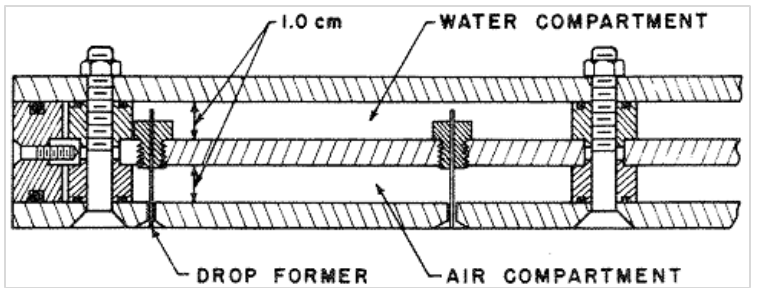
Figure 9. Box tank with drippers with air and water chambers [32] (Reprinted/adapted with per- mission from Ref. [Onstad et al., 1981]).